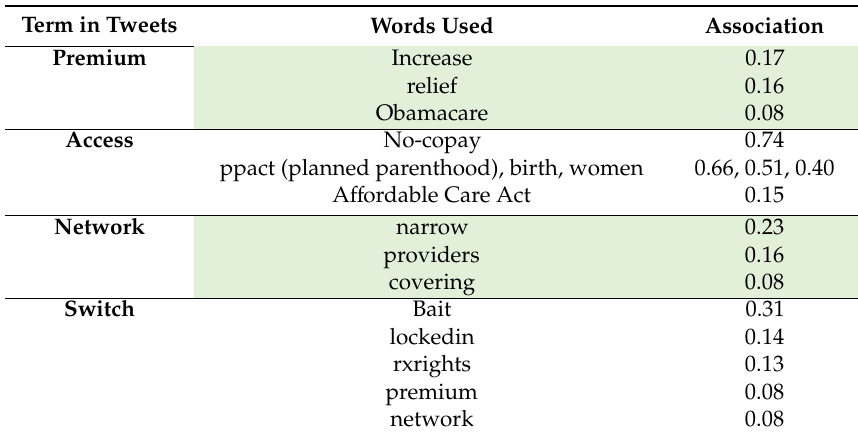
Table 2. Words associated with premium, access, and network.